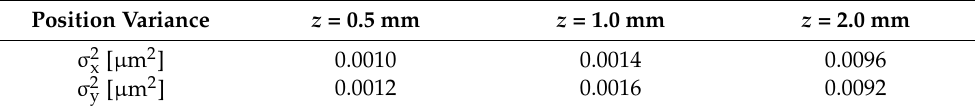
Table 1. The corresponding position variance of a trapped particle at different sample planes.